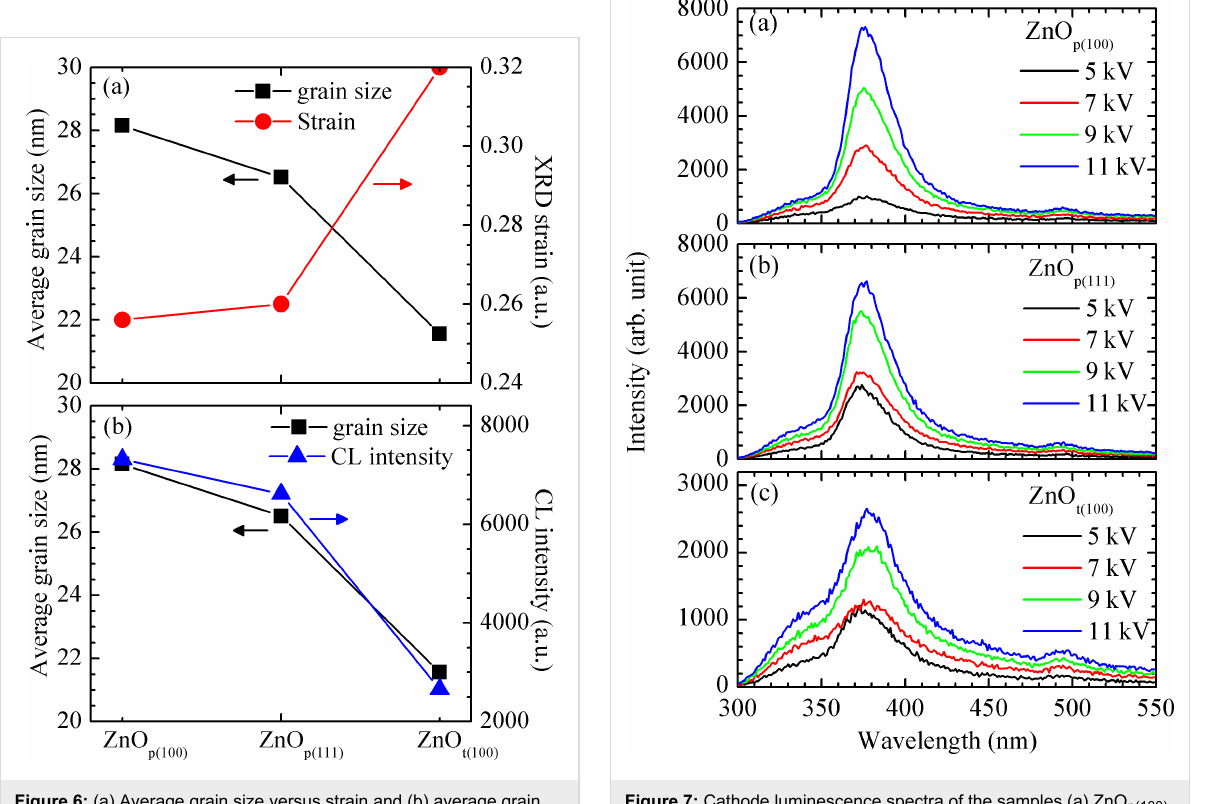
Figure 6: (a) Average grain size versus strain and (b) average grain size versus cathode luminescence (CL) intensity of the samples ZnO p(100) , ZnO p(111) , and ZnO t(100) .